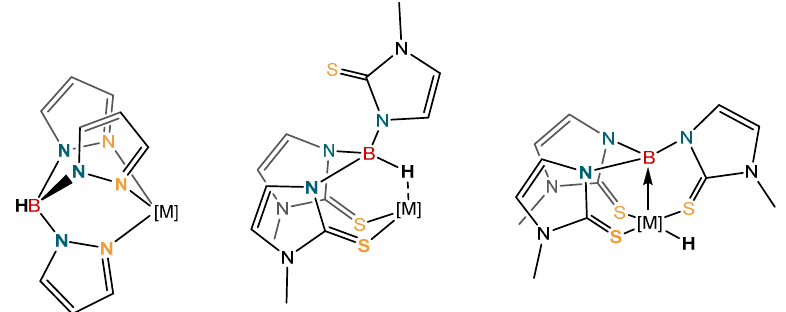
Figure 1. Selected examples of ligands in which the borohydride unit is positioned away from the metal center (left), directed towards the metal center (middle), and a system in which a B ‒ H activation has occurred (right). The additional atom between boron and the donor atoms is typically necessary for metal ‒ boron bond formation.